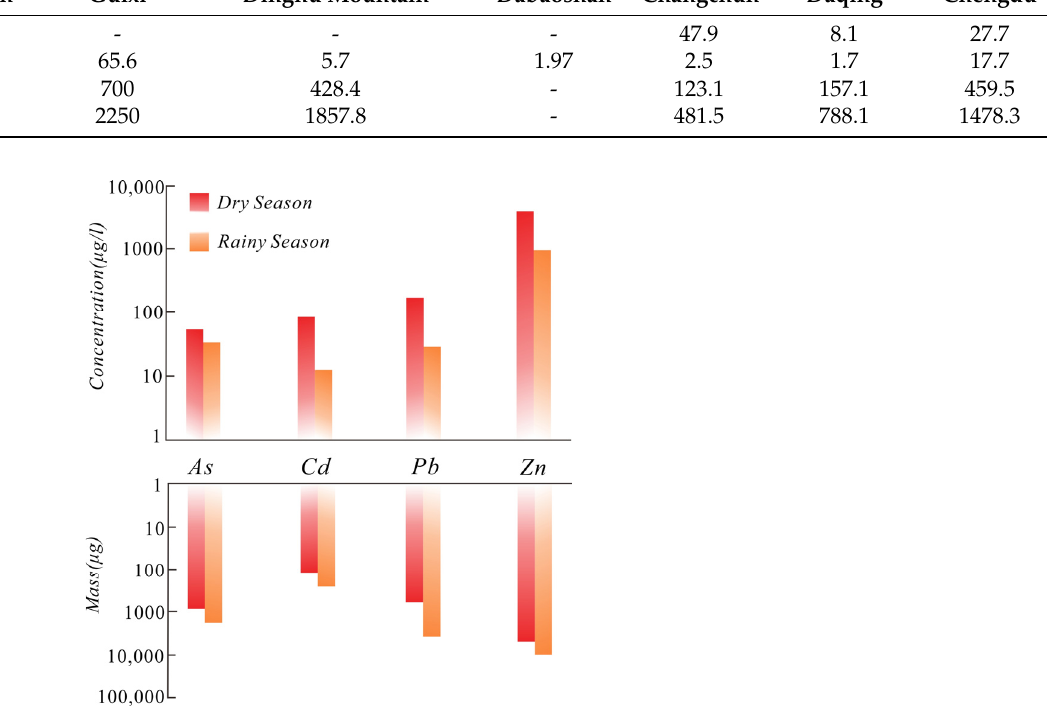
Figure 3. Comparison of characteristics of heavy metals in the atmosphere in di ff erent seasons. Log- rithmic coordinates. Comparison of di ff erences in concentration and quality of heavy metals in at- mospheric deposition during the dry season and rainy season.